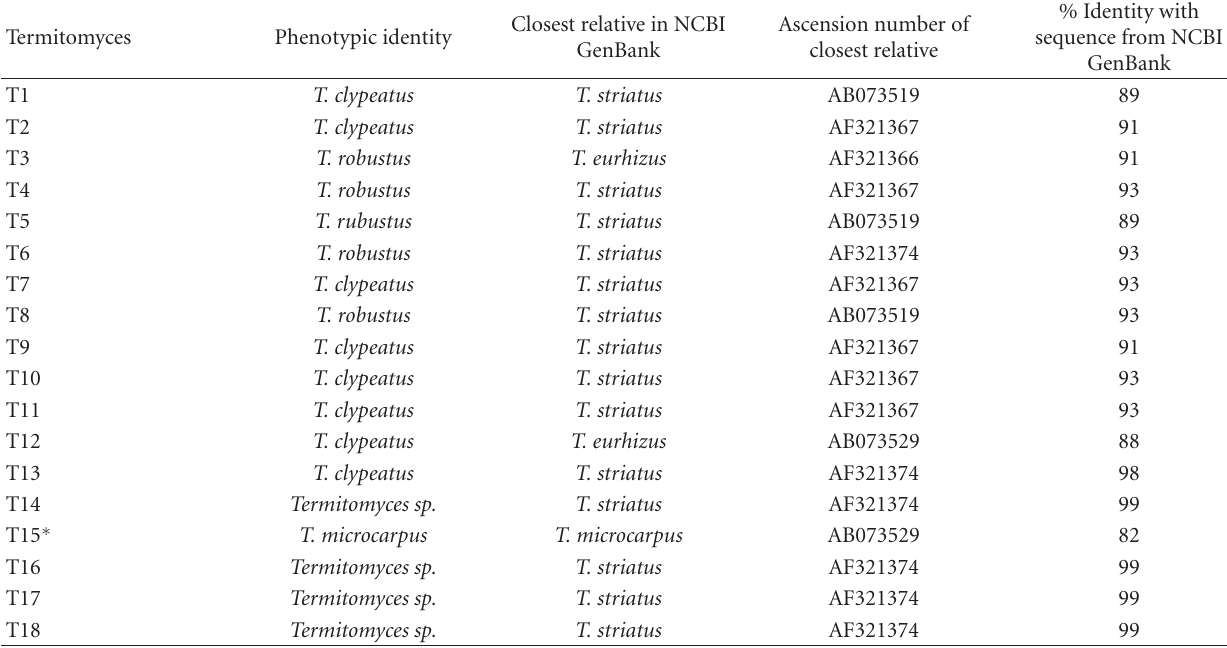
Table 2: Genomic identification based on the ITS gene sequences of Termitomyces species collected from Ondo and Ekiti States, Nigeria. Termitomyces